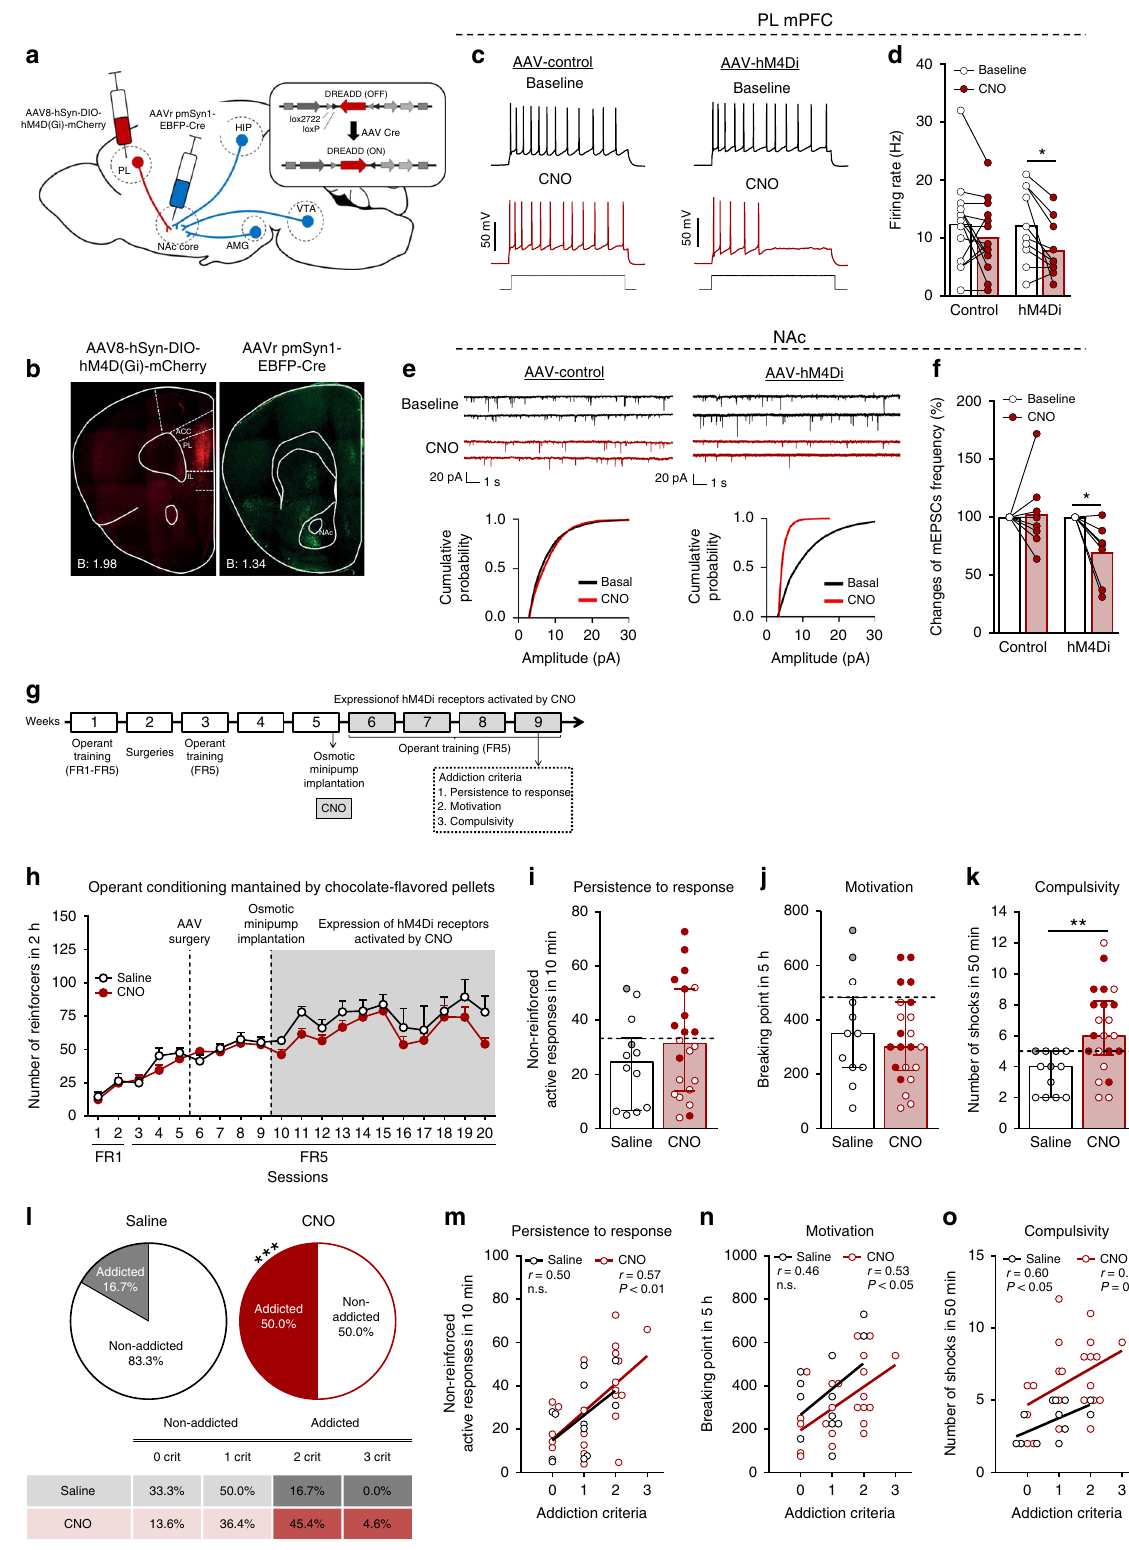
during the operant conditioning maintained by chocolate- fl avored pellets, indicating that the inhibition of PL-NAc core projection did not affect the reinforcing effects of these pellets (Fig. 3h). In contrast, this speci fi c manipulation of the PL-NAc projection produced a robust increase in the food addiction compulsivity criterion ( t -test, P < 0.01, Fig. 3i – k). Thus, mice